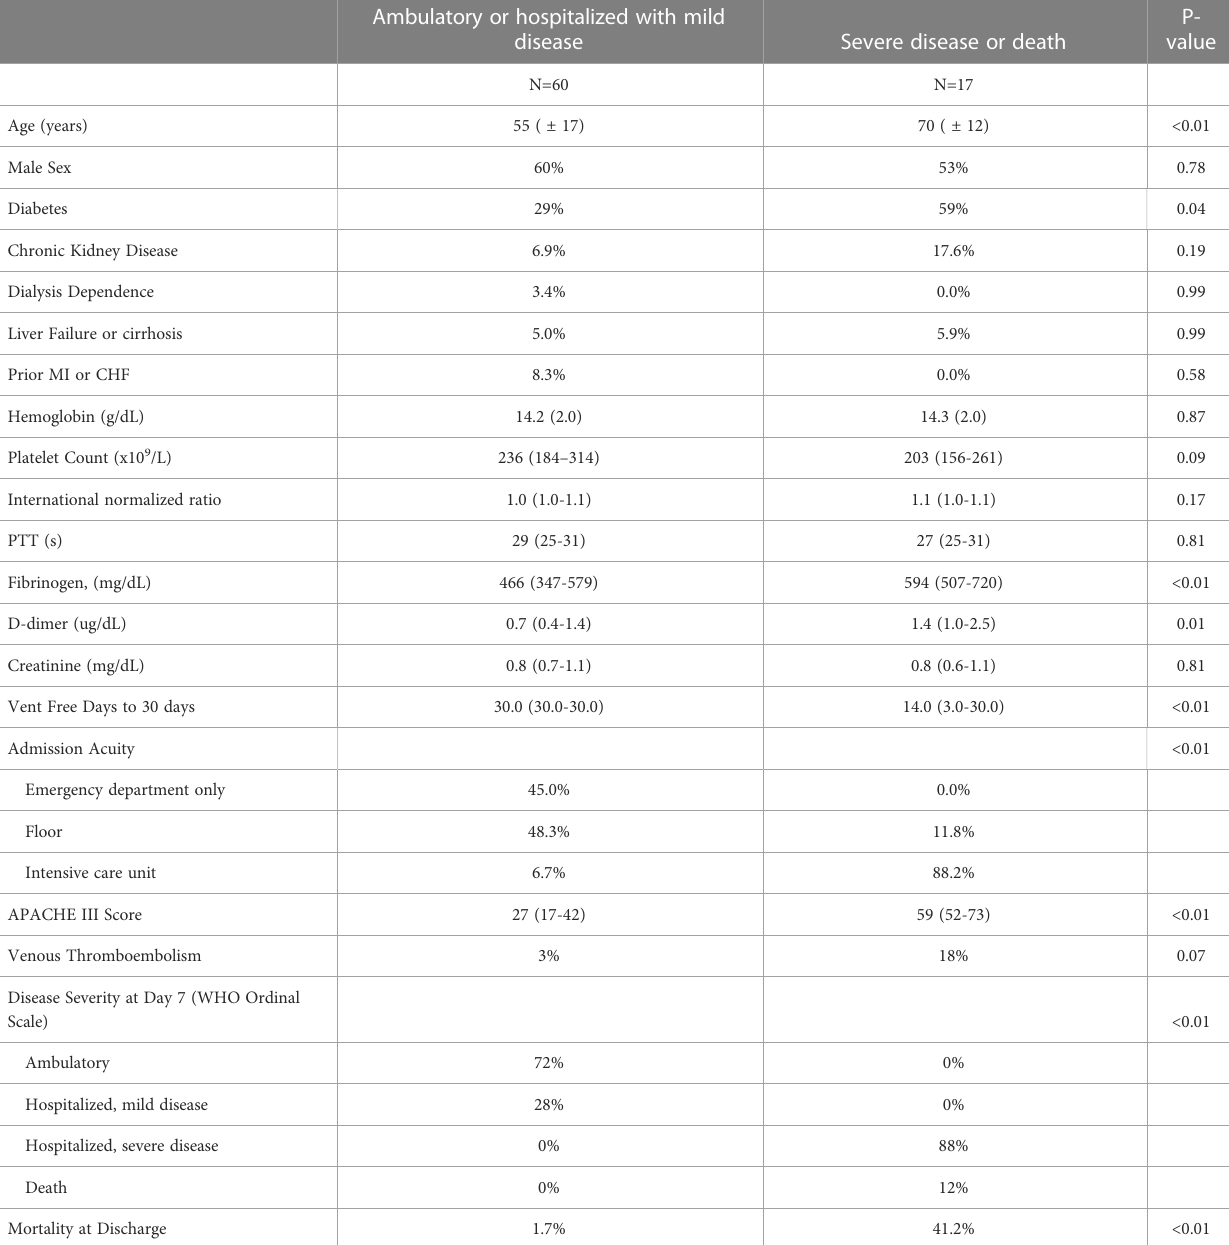
TABLE 1 Characteristics of COVID-19 patients by ultimate disease